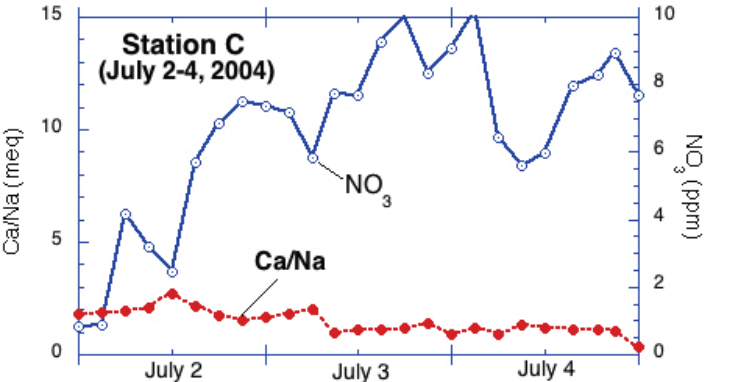
Fig. 14 Temporal variations in Ca/Na ratios (meq) and dissolved nitrate at station C on the Chingshui River, 2–4 July 2004. Note the order-of-magnitude increase in dissolved nitrate on early 2nd July. 2nd July, coincident with the breaching of the Tsaoling landslide lake (see Fig. 3). Presumably